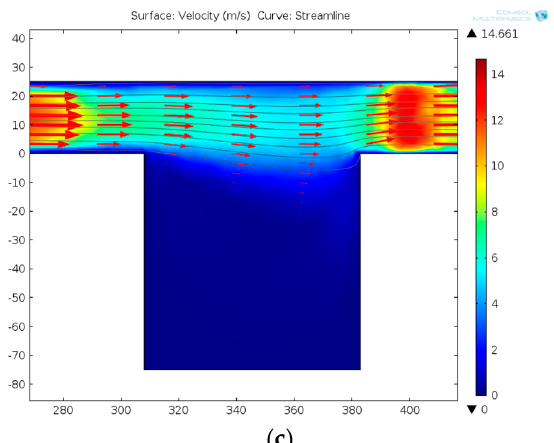
Figure 3. The streamline distributions of the A-A section view at different rates. As the rate increases, the streamline in the channel will be straighter, so a cell will more easily arrive at the trap site. ( a ) 5 mm/s (equivalent to the volume flow rate in microchannle 0.1875 μ L/min), ( b ) 50 mm/s (equivalent to the volume flow rate in microchannle 1.875 μ L/min), and ( c ) 500 mm/s (equivalent to the volume flow rate in microchannle 18.75 μ L/min).